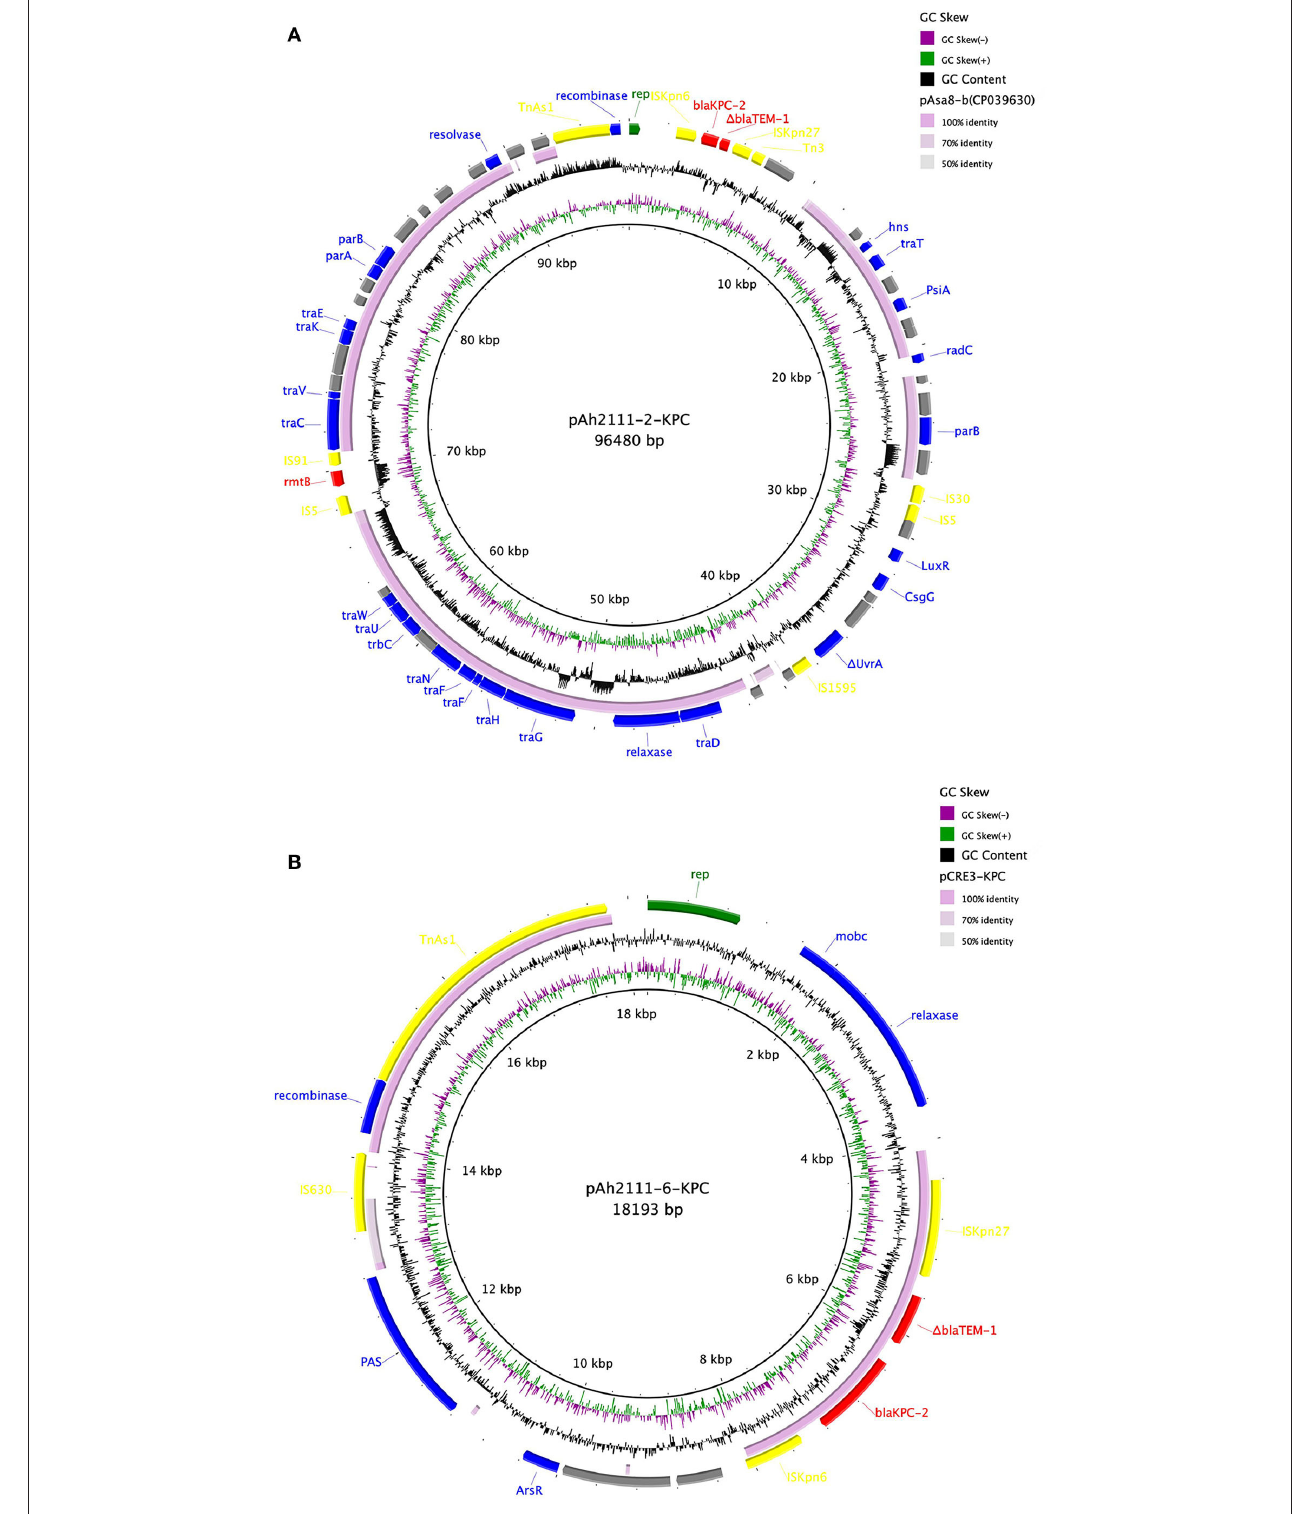
FIGURE 1 | Comparison of two bla KPC − 2 -carrying plasmids pAh2111-2-KPC (A) and pAh2111-6-KPC (B) with the reference plasmids. The five circles from inside to outside displayed the scale in kilobase pairs, the GC skew, the GC content, level similarity to the reference plasmids, and annotation of the plasmids tested in this study,